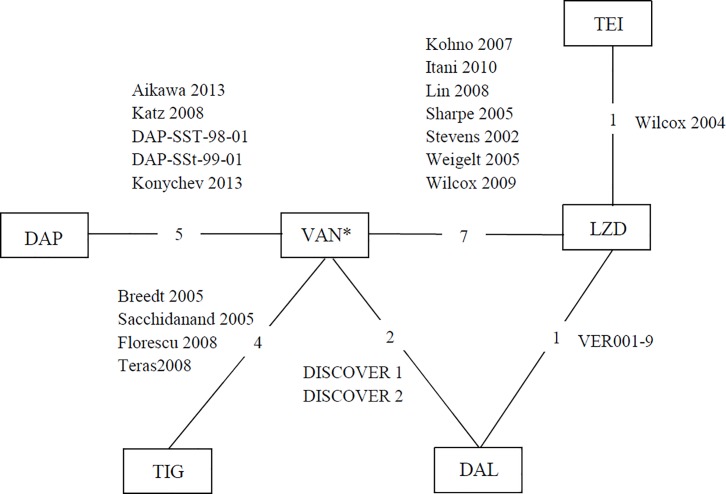
Network of the studies used in the meta-analysis.Abbreviations: DAL: dalbavancin; DAP: daptomycin; LZD: linezolid; TEI: teicoplanin; VAN: vancomycin; TIG: tigecycline. *Includes studies where the comparator was vancomycin, vancomycin plus aztreonam. Or vancomycin plus conventional treatment. Each node represents a treatment and the connecting lines indicate pairs of treatments that have been directly compared in one RCT. The numbers in the connecting lines indicate the number of relevant studies for each treatment comparison.